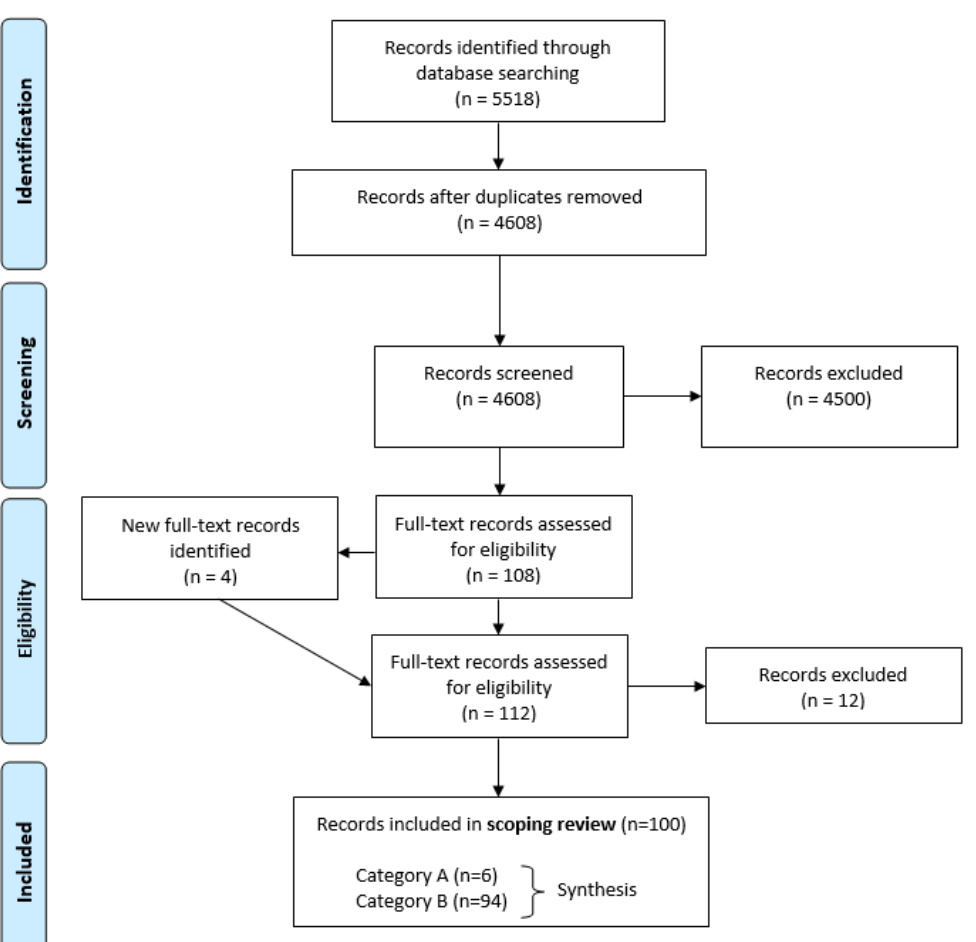
Figure 2. Literature search, screening results, and analysis displayed as a PRISMA flow diagram. Figure design adapted from Moher et al. 2009 [3]. Note: PRISMA, Preferred Reporting Items for Systematic Reviews and Meta-Analyses (http://www.prisma-statement.org).